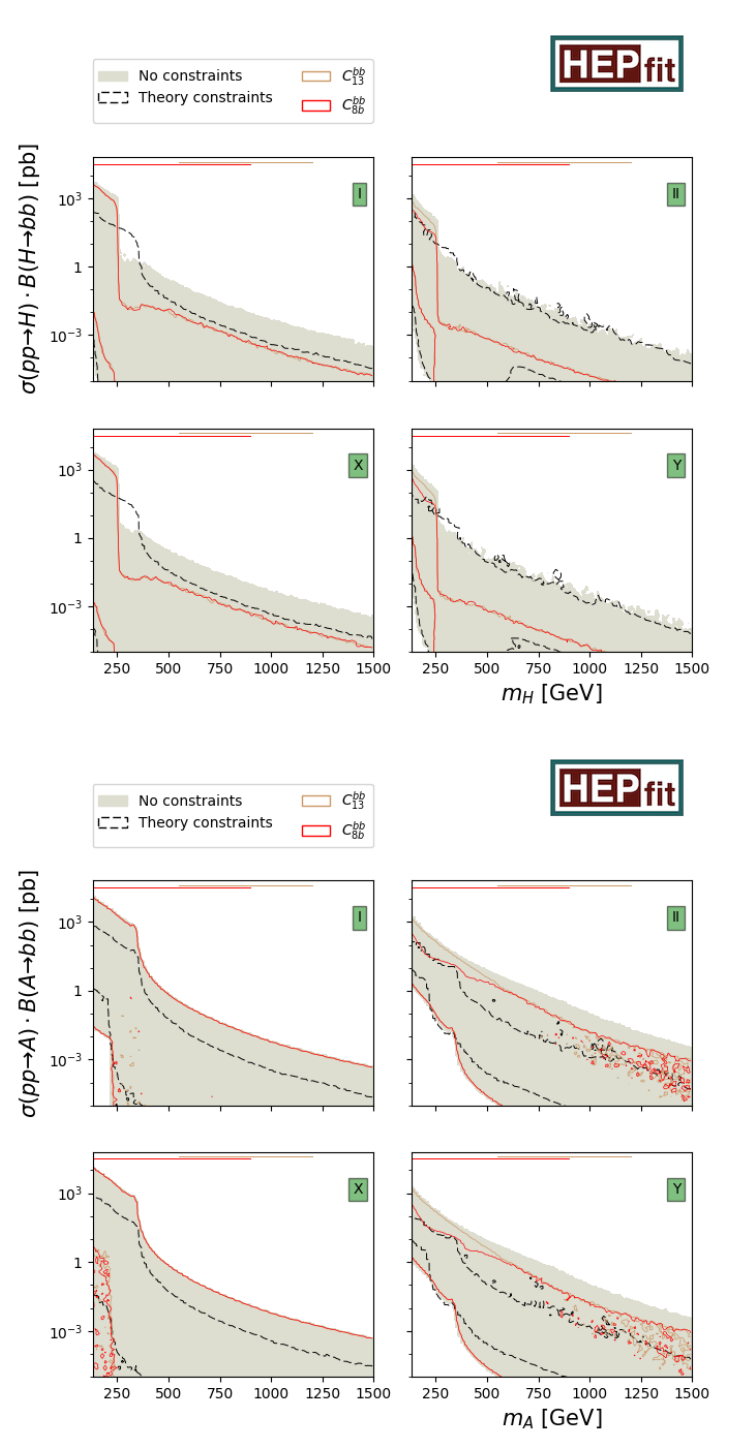
Figure 6 . 95% contours of the single searches for H=A ! b (cid:22) b in the (cid:27) (cid:1) B vs. m four 2HDM types (top: H , bottom: A ). For details, see text.